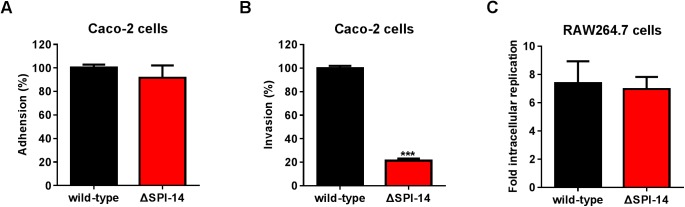
Lack of SPI-14 decreased S. Typhimurium invasion of Caco-2 epithelial cells.(A, B, C) Adhesion (A), invasion (B) and macrophage replication assays (C) of wild-type and SPI-14 mutant. Caco-2 cells or RAW264.7 cells were infected with wild-type S. Typhimurium or SPI-14 mutant at a multiplicity of infection (MOI) of 10. Adhesion and invasion ability of SPI-14 mutant were reported as percentage relative to the wild-type. Replication in RAW264.7 cells was determined by the ratio of the number of intracellular bacteria at 16 h post-infection to the number of bacteria at 2 h post-infection. Data are representative of at least three independent experiments and are presented as mean ± SD; P value was determined by student’s t test (***P<0.001).